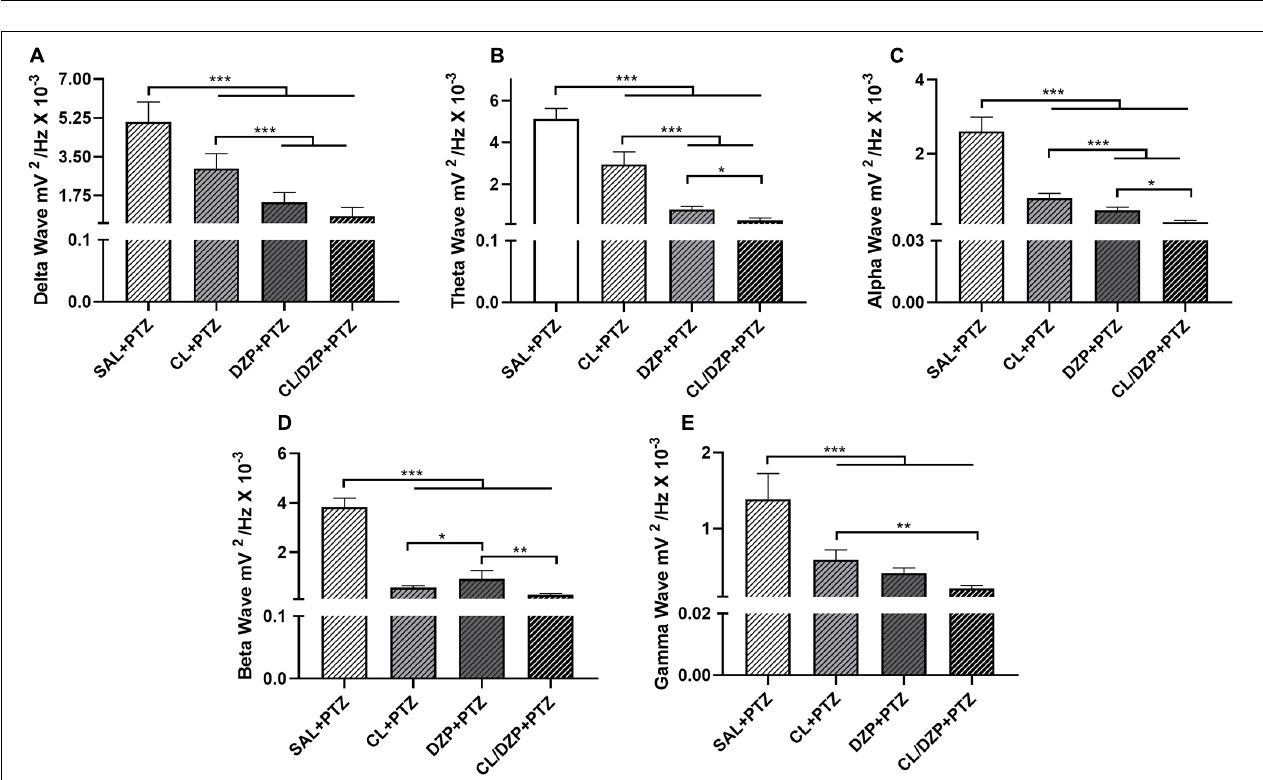
FIGURE 3 | Total linear brainwave power recorded by electroencephalography. (A) Quantitative distribution of the total linear power of the brainwaves of the animals that received saline on the fifth day. (B) Quantitative distribution of the animals that were pretreated with saline and received saline or pentylenetetrazol on the fifth day. (C) Quantitative distribution of the total linear power of the brainwaves of the animals that received pentylenetetrazol on the fifth day. The data are expressed as the mean ± SD ( n = 9 per group); *** p < 0.001. SAL, saline; CL, Curcuma longa ; DZP, diazepam; PTZ, pentylenetetrazol.